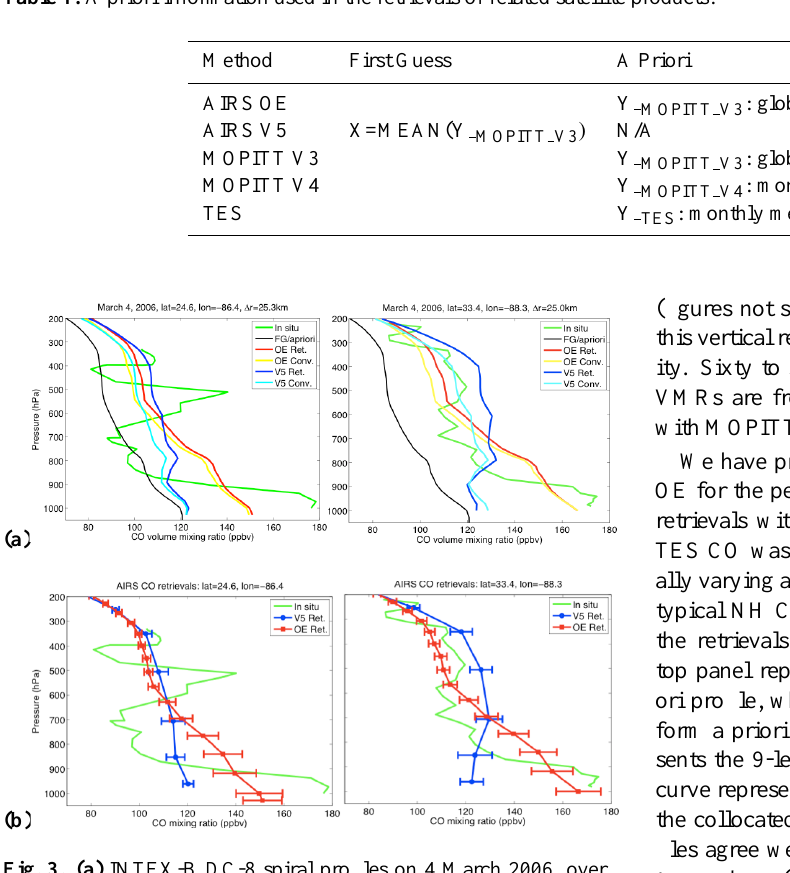
Table 1. A priori information used in the retrievals of related satellite products.